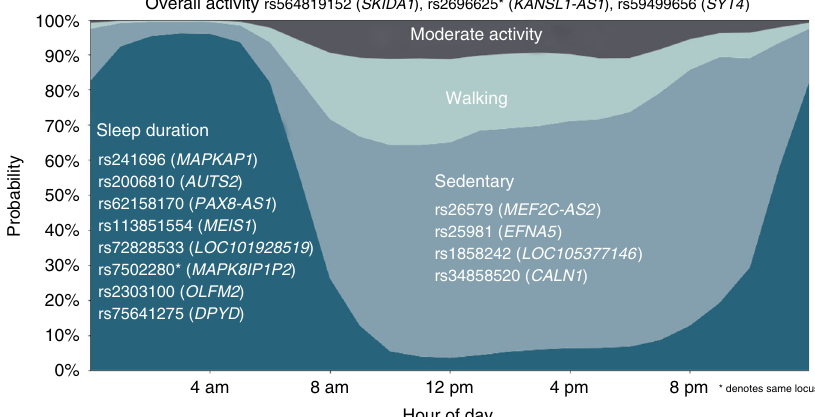
Fig. 1 Genome-wide signi fi cant (5 × 10 − 9 ) loci associated with accelerometer-measured variation in sleep duration and physical activity behaviours in 91,105 UK Biobank